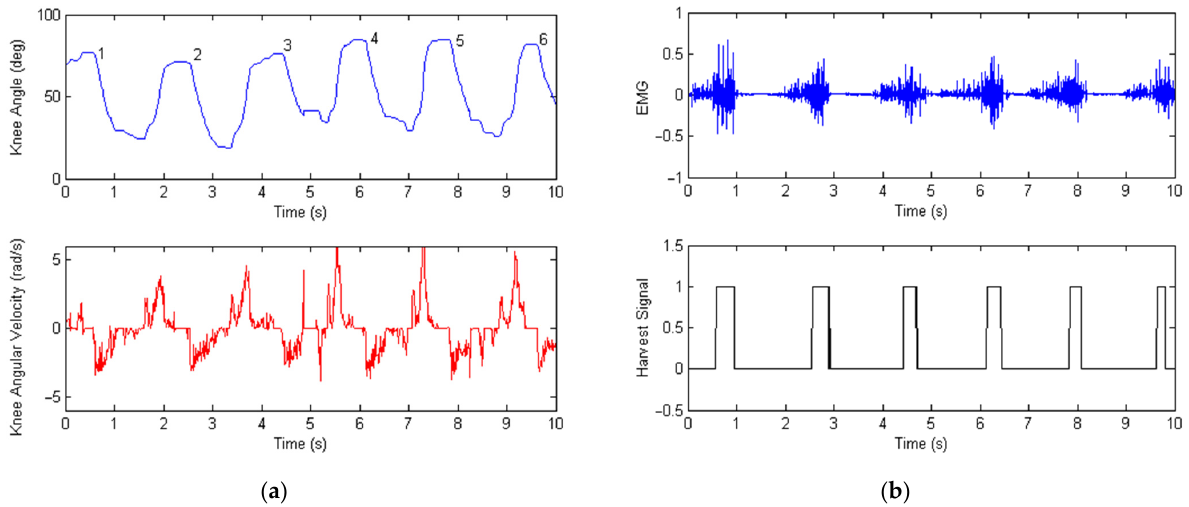
Figure 13. Plots of the measured exoskeleton knee angle and EMG thigh muscle activity with energy harvesting control signals when the walking speed of the human subject was 1.2 km/h downstairs. ( a ) Measured knee angular displacement and velocity of the Bowdencable-actuated knee exoskeleton during movement down stairs. ( b ) Measured EMG signal of the thigh muscle activity and the controlled energy harvest signal.